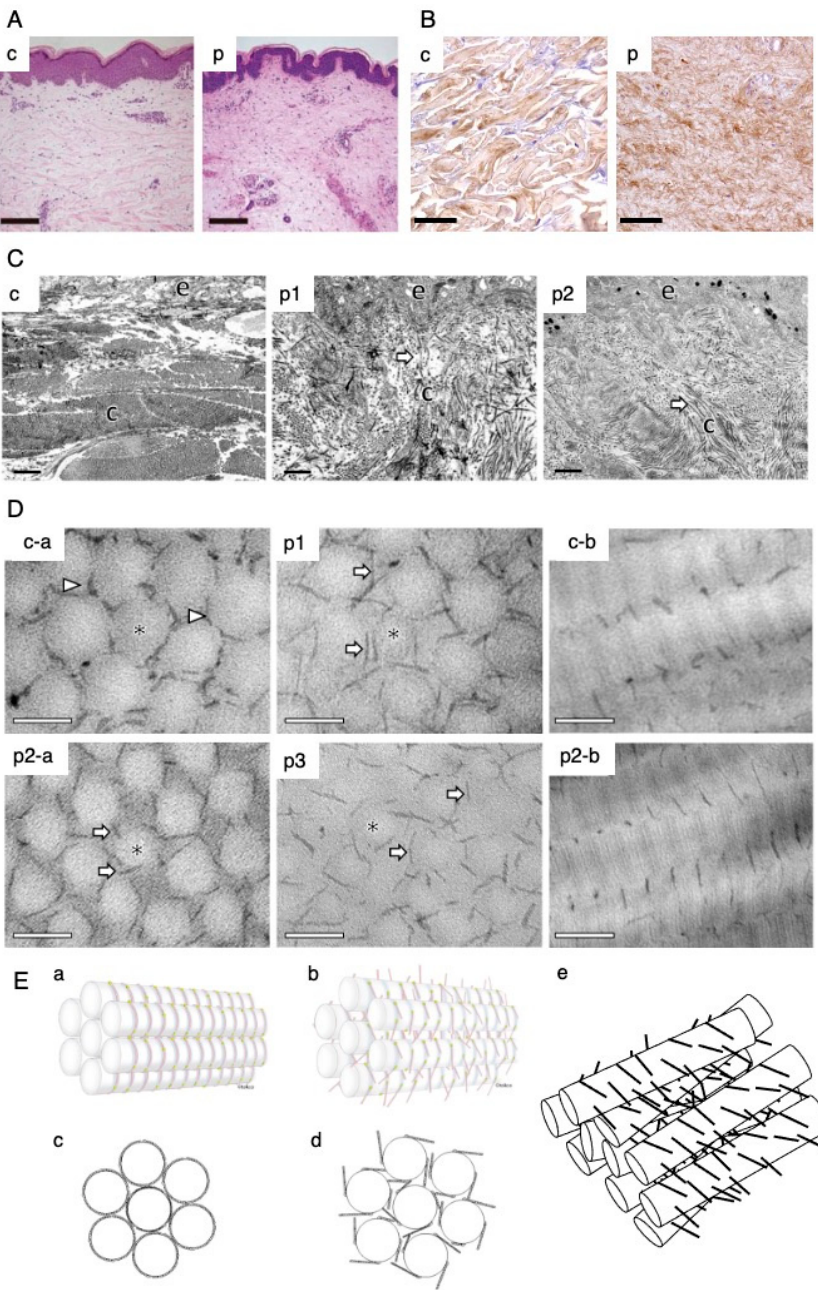
Figure 4. Skin pathology of mcEDS- CHST14 . ( A ) Light microscopy (hematoxylin and eosin staining). In the skin specimen from a patient with heterozygous variants Pro281Leu / Cys289Ser (panel p), fine collagen fibers are present predominantly in the reticular to papillary dermis with marked reduction of thick collagen bundles; thick collagen bundles are observed in a skin specimen from a healthy control volunteer (panel c) [6]. ( B ) Immunohistochemical staining for decorin core protein. Decorin core protein is present on collagen fibers in thick bundles in a skin specimen from a healthy control volunteer (panel c), but on thin and filamentous collagen fibers without clear boundaries in a skin specimen from a patient with heterozygous variants Pro281Leu / Cys289Ser (panel p) [31] ( C ) Transmission electron microscopy. Collagen fibrils are regularly and tightly assembled in a skin specimen from a healthy control volunteer (panel c), but are dispersed in the papillary to reticular dermis in skin specimens from a patient with heterozygous variants Pro281Leu / Tyr293Cys (panel